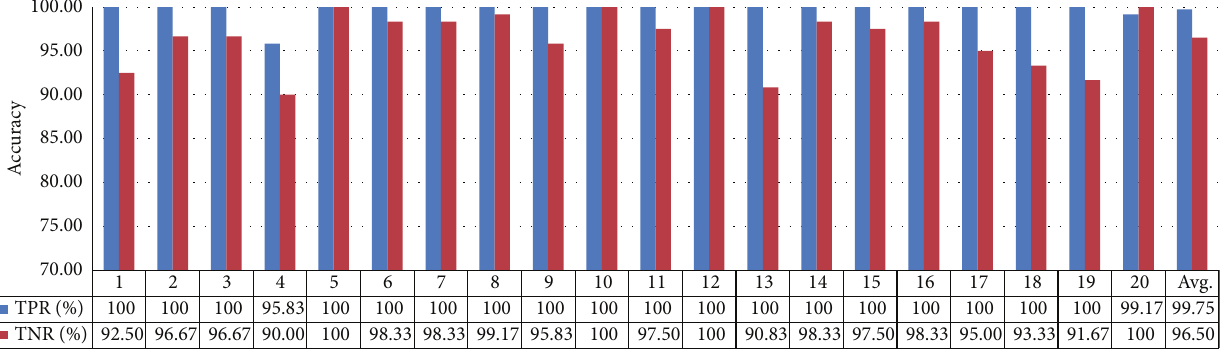
Figure 20: Accuracy of selecting the heater using gaze estimation method 2.